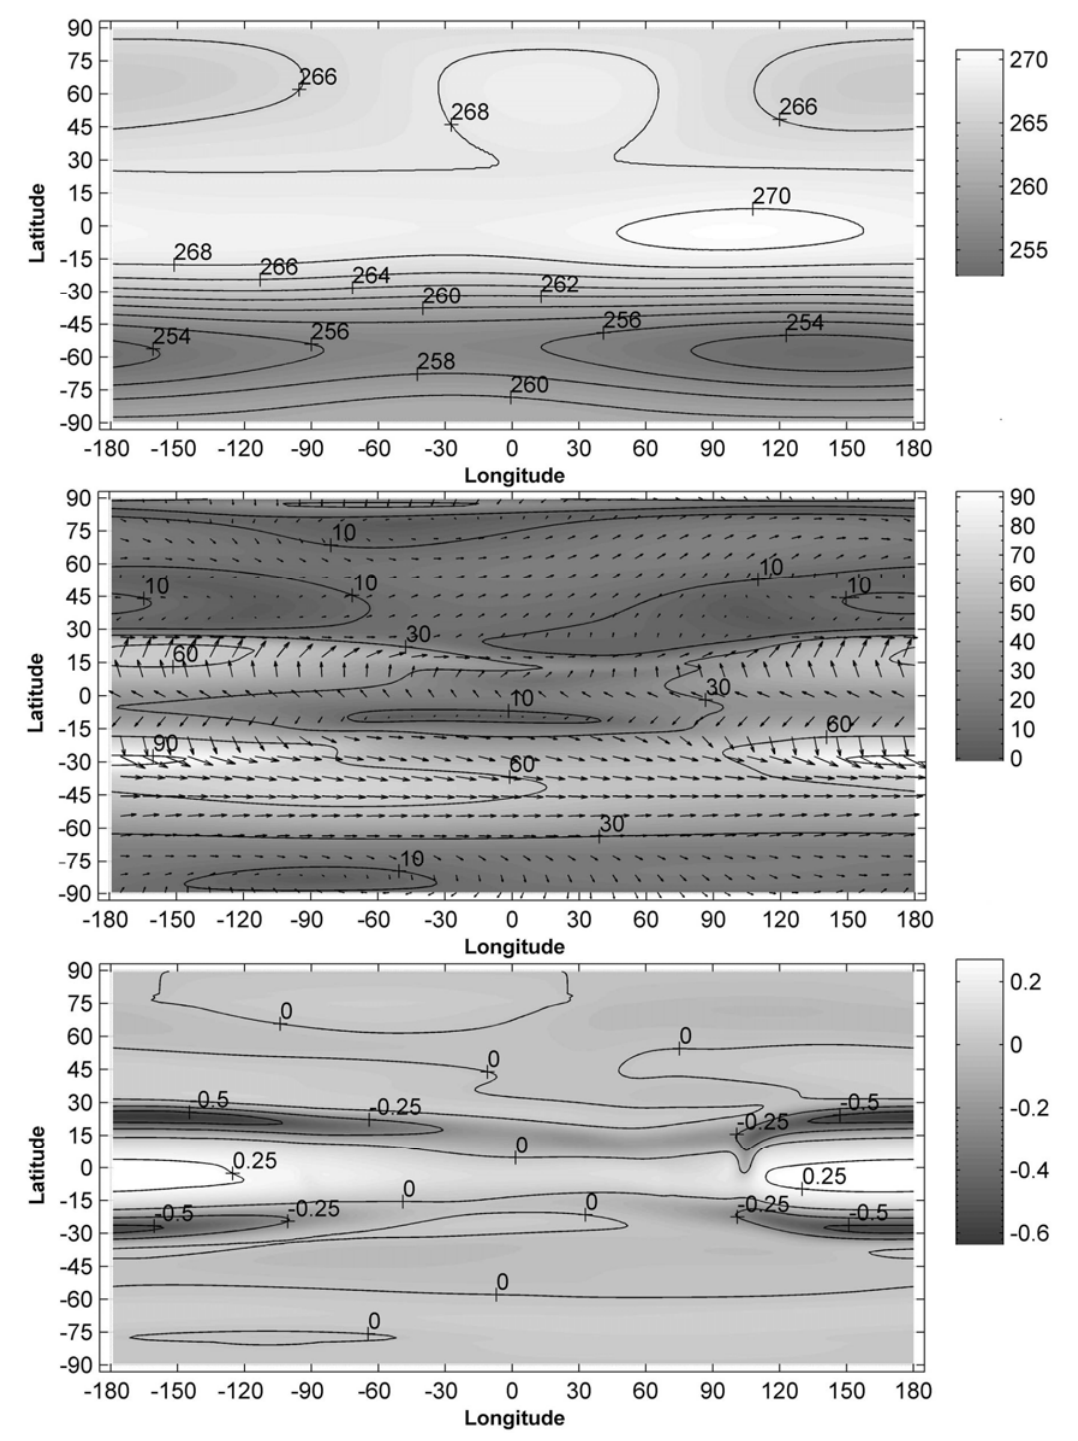
Figure 2. The same as in Figure 1 but obtained for 16